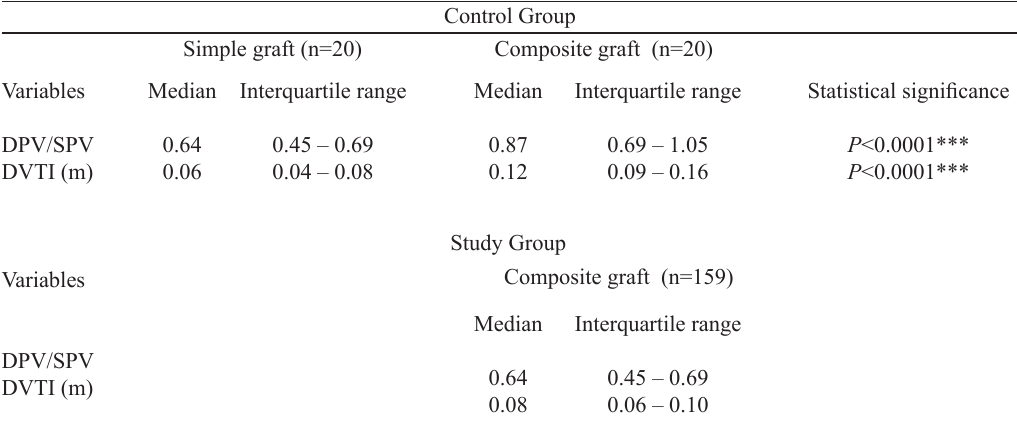
Table 1. The medians and interquartile ranges (lower and upper quartiles) of the variables analyzed during the standardization and validation phases by type of graft used.